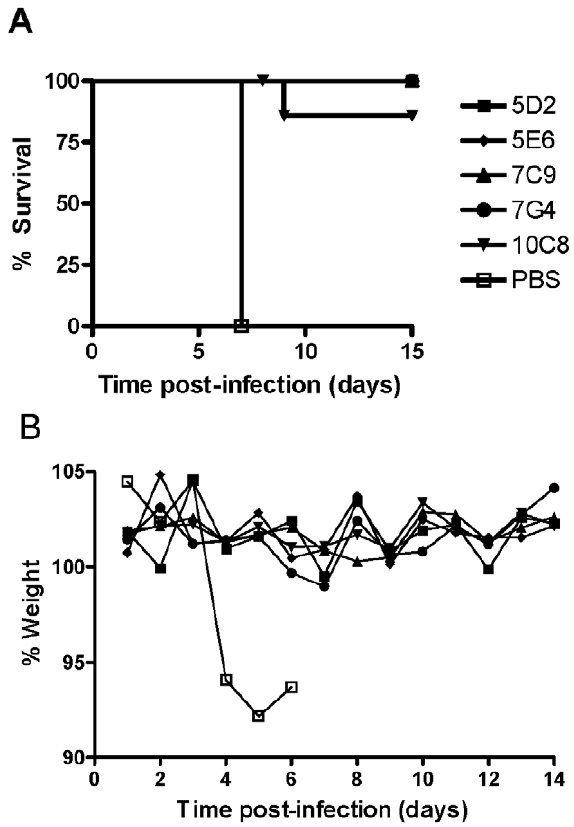
Figure 2. A treatment regimen using a combination of MAbs improves survival in GA-ZEBOV-infected guinea pigs. Guinea pigs were infected with 1000 LD 50 of GA-ZEBOV i.p., then treated on 1 dpi with 3 mg of one of the non-neutralizing MAb i.p. (5D2, 5E6, 7C9, 7G4, or 10C8), followed by an i.p. treatment on 2 dpi with a combination of the 3 neutralizing MAbs ( 2 mg 4G7 + 1 mg 1H3 + 1 mg 2G4). The control animals received PBS i.p.. The percent survival ( A ) and average percent of the group weight ( B ) was determined.